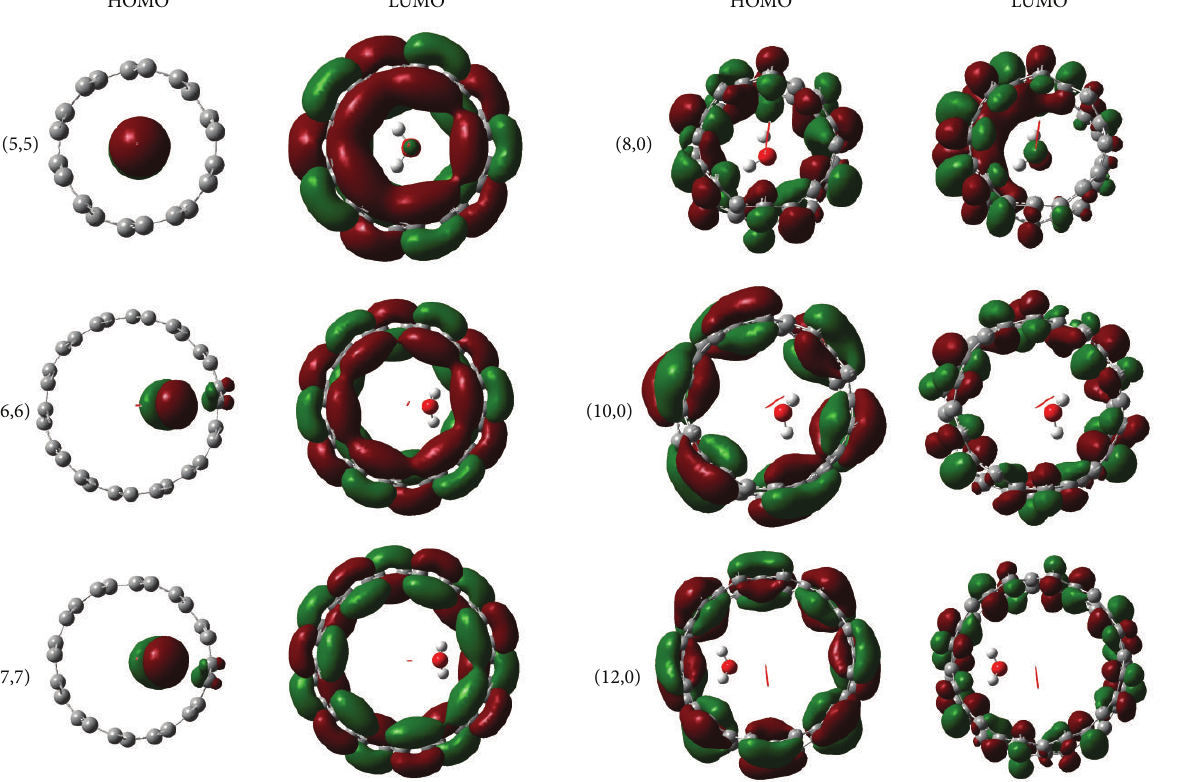
Figure 2: HOMO and LUMO of the CNTs and water at the optimized geometry.